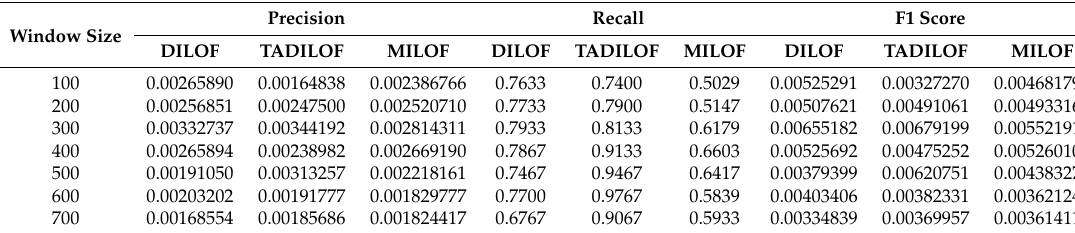
Table 9. Precision, recall, and F1 score on SMTP dataset.